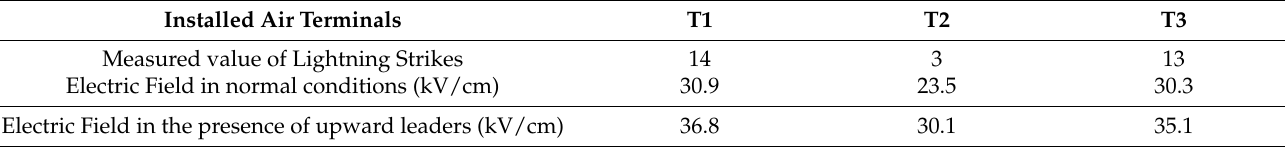
Table 1. Number of strikes and electric field on LATs of a gable